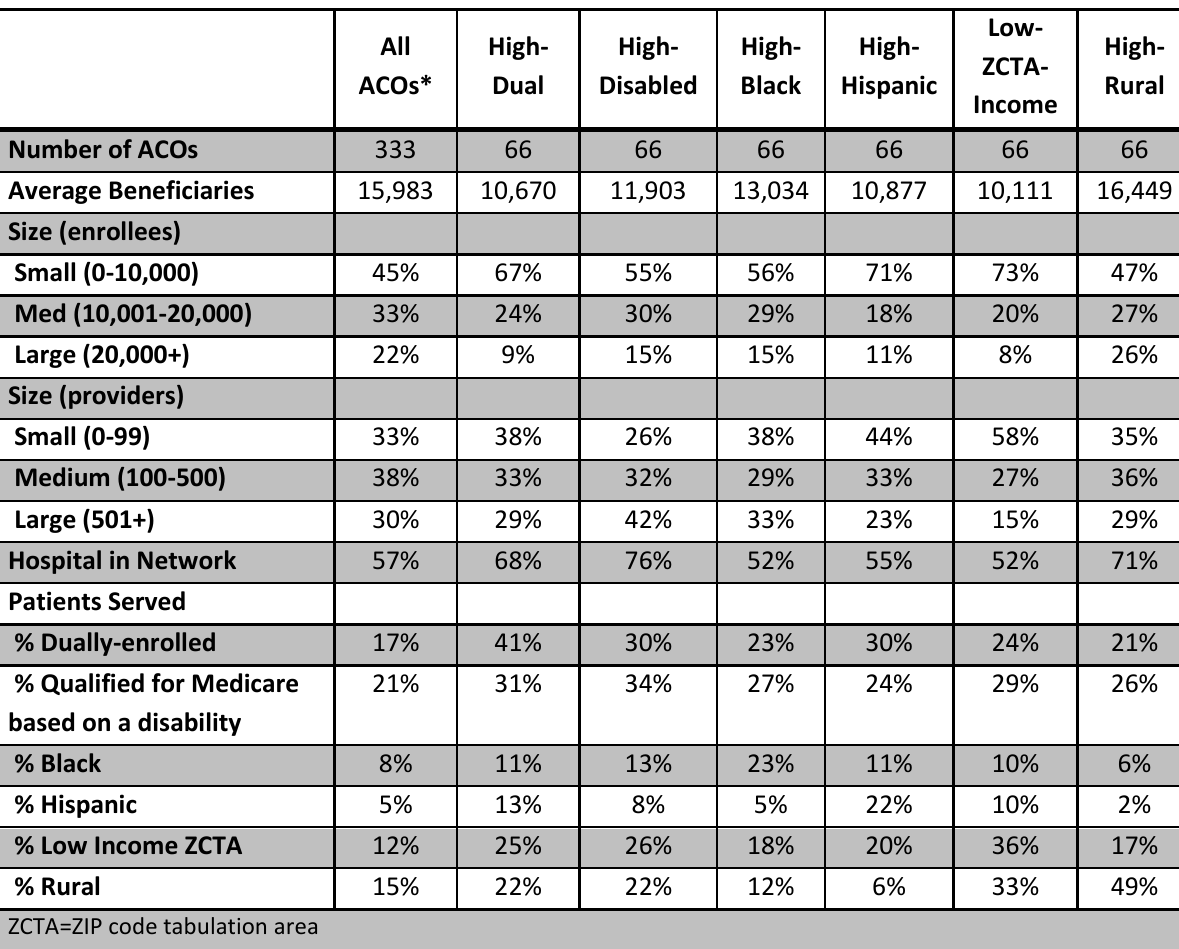
Table 9.2: Medicare Shared Savings Program ACO Characteristics, by Proportion of Socially At-Risk Beneficiaries